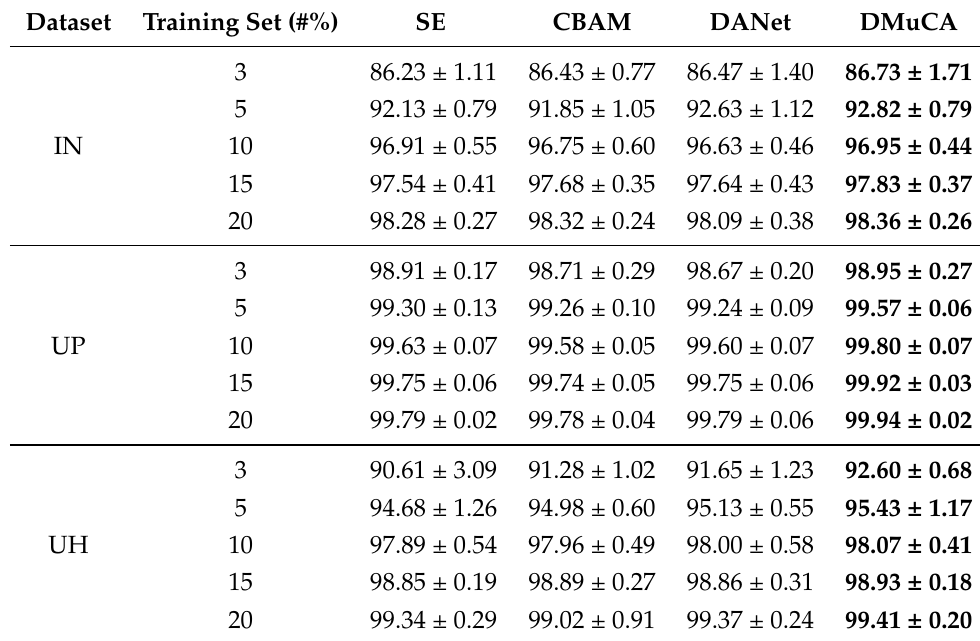
Table 9. Comparison of the DMuCA module with some classical attention mechanisms (OA%). The best results are highlighted in bold